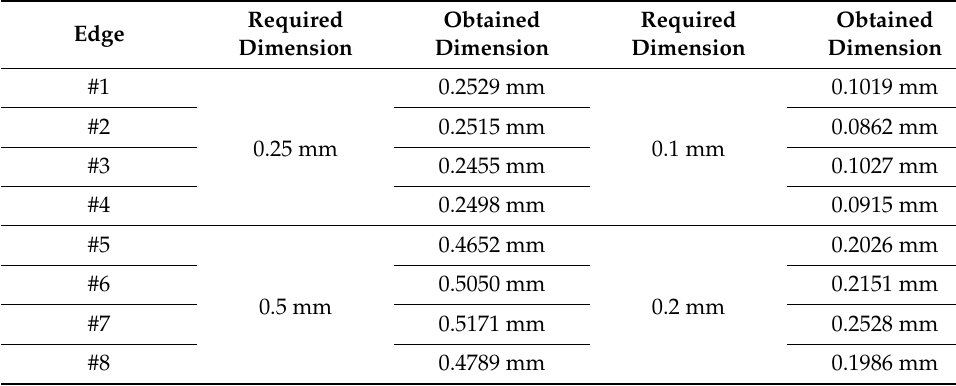
Table 3. Required and obtained values for elliptical fillets.